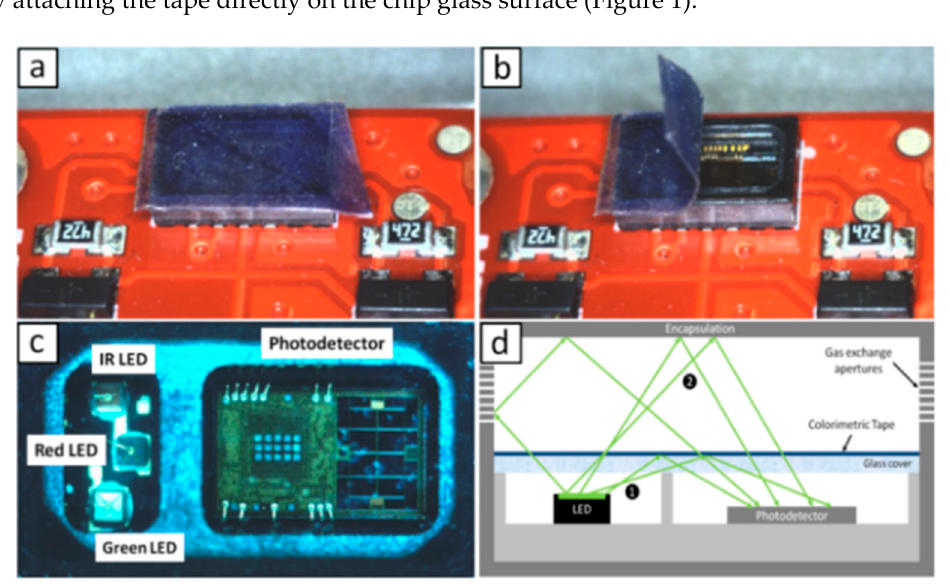
Figure 1. ( a , b ) Optical images of the MAX30105 component covered with a colorimetric tape. ( c ) A detailed image of the sensor chip with the red, green and IR LEDs and the photodetector. ( d ) Scheme of the proposed configuration: the photodetector will measure  the reflected light and  the transmitted light through the colorimetric tape (i.e., absorbance of the color